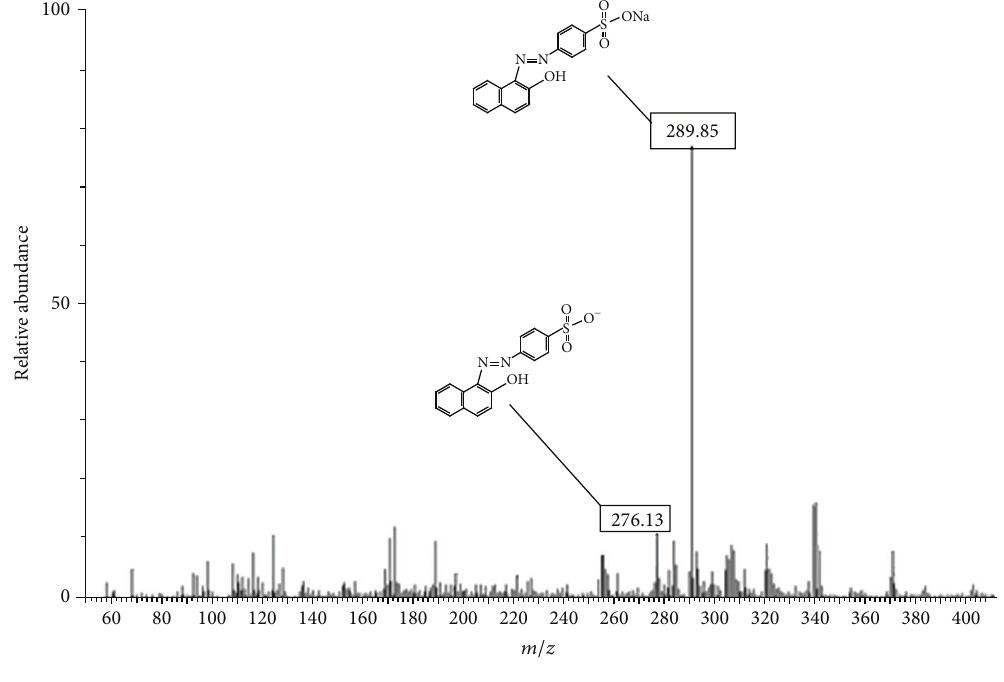
Figure 3: MS spectra of OII after treatment by BCP.